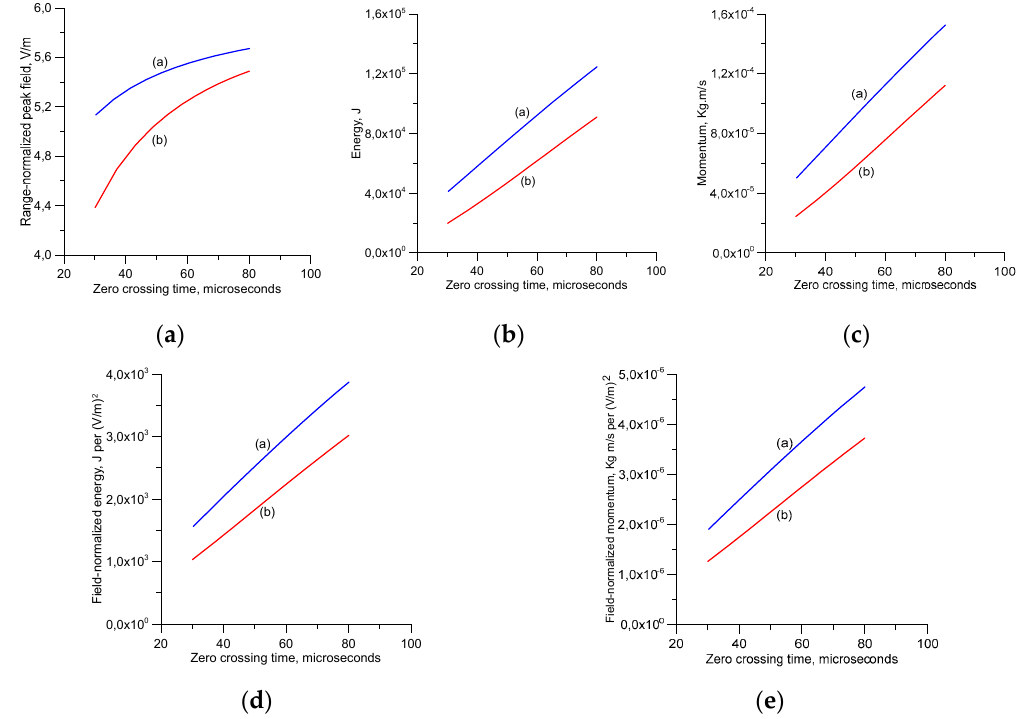
Figure 4. Results pertinent to first return strokes simulated by MTLL and MTLE models with a peak return stroke current of 30 kA and a return stroke speed equal to 10 8 m / s. ( a ) The range-normalized (to 100 km) peak amplitude of the radiation field as a function of the zero-crossing time; ( b ) The energy radiated as a function of the zero-crossing time; ( c ) The momentum radiated as a function of the zero-crossing time ( d ) The field-normalized energy (as defined by dividing the energy by the square of the radiation field peak at 100 km); ( e ) The field-normalized momentum (as defined by dividing the momentum by the square of the radiation field peak at 100 km). Curve (a) corresponds to the MTLL model, and curve (b) corresponds to the MTLE model.